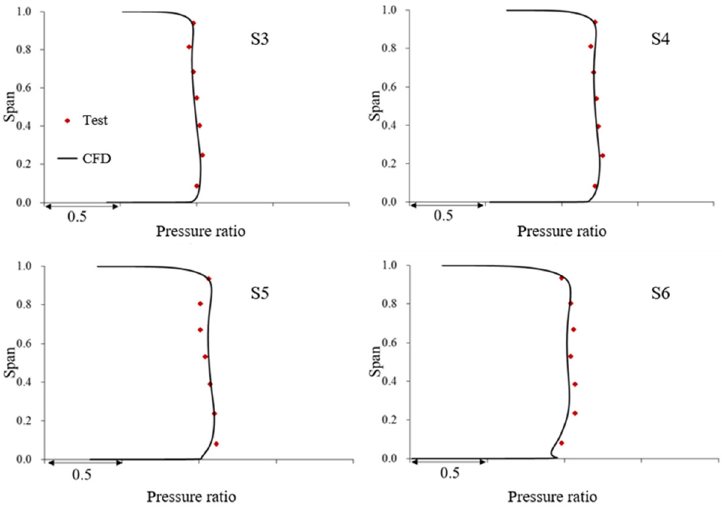
Figure 7. Static pressure spanwise distribution at inlet of stators (static pressure/inlet total pressure).